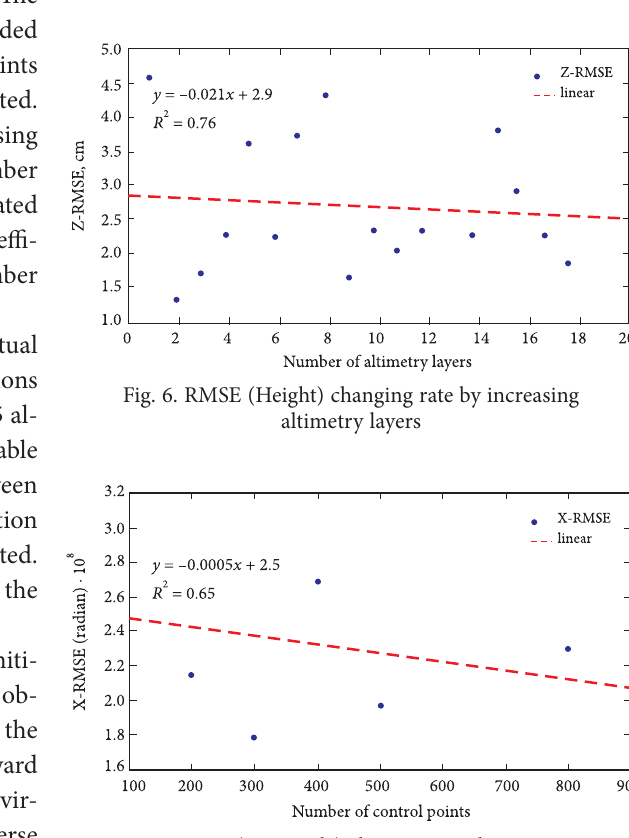
Fig. 5. RMSE (Latitude) changing rate by increasing altimetry layers